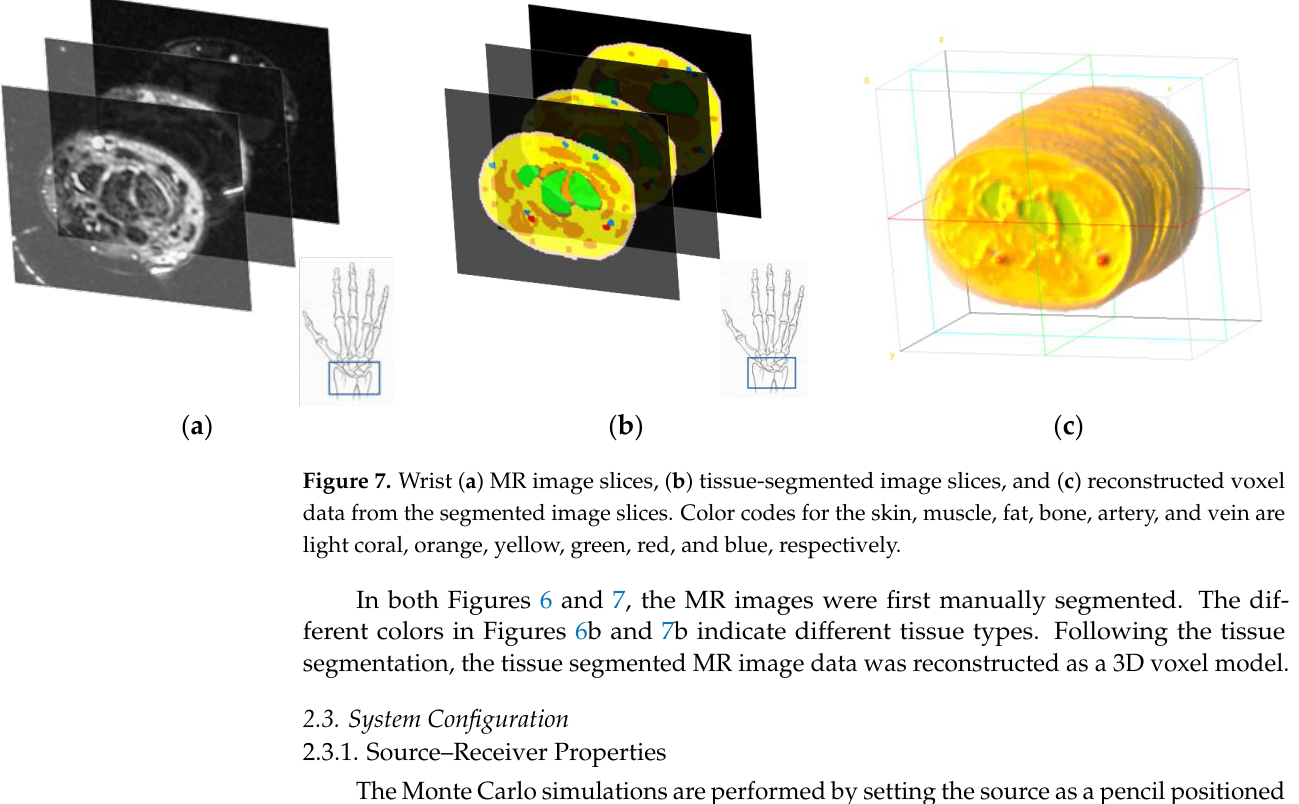
Figure 6. Fingertip ( a ) MR image slices, ( b ) tissue-segmented image slices, and ( c ) reconstructed voxel data from the segmented image slices. Color codes for the skin, muscle, fat, bone, and nail are light coral, orange, blue, green, and red, respectively. Wrist The wrist region of the MR slice was segmented for the skin, muscle, fat, bone, artery, and vein tissues. Similar to the fingertip region segmentation, the wrist region was segmented by considering the ligaments and tendons as muscular-type tissues. Figure 7 shows the segmentation steps of the wrist region.